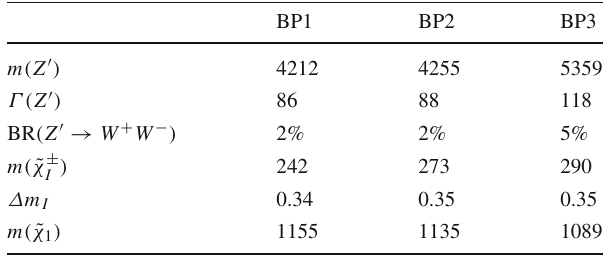
Table 1 The benchmark points used in our study. We give the mass and width of the Z (cid:2) and the masses of the lightest inert chargino and the lightest active neutralino in GeV’s. We choose g N = 0 . 55 for all bench- marks. The mass splitting Δ m I , also given in GeV’s, is that between the inert chargino and neutralino. All benchmarks satisfy the relic